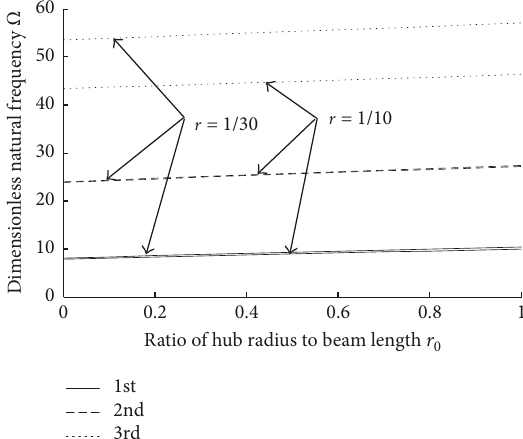
Figure 10: The first three-order dimensionless natural frequencies with dimensionless angular speed of the hub for different 𝑟 0 = 0, 0.5, 1 at 𝛽 = 0.3 .